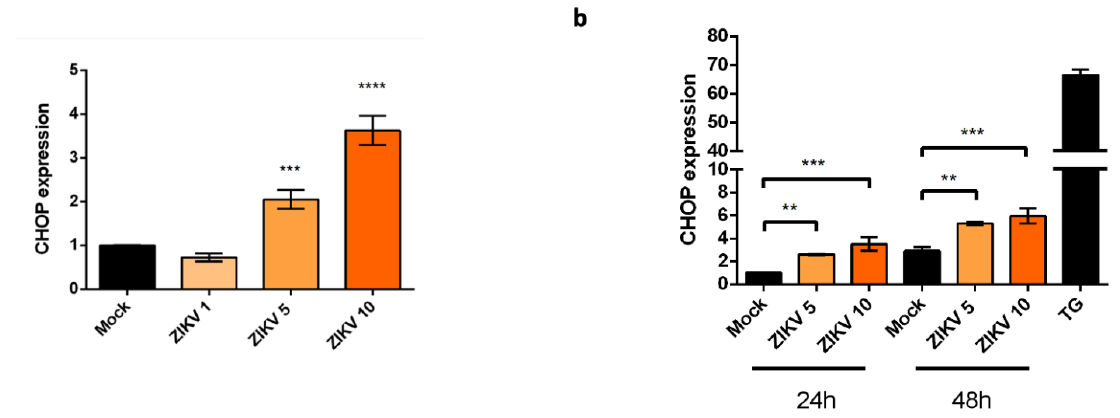
Figure 3. CHOP expression is upregulated at the transcriptional level in ZIKV infected cells. ( a ): qRT-PCR analysis of CHOP mRNA was performed in A549 cells harvested 24 h after being infected with ZIKV at different MOI (1, 5 and 10). CHOP mRNA expression was normalized to the GAPDH mRNA level. Data were presented as mean SEM ( n = 3). **** p < 0.0001, *** p < 0.001 vs. mock. ( b ): qRT-PCR analysis of CHOP mRNA was performed in A549 cells harvested at 24 h and 48 h after being infected or not with ZIKV at MOI 5 and MOI 10 or treated with TG for 6 h. CHOP mRNA expression was normalized to the GAPDH mRNA level. Data were presented as mean and SEM ( n = 3). *** p < 0.001, ** p < 0.01 vs.